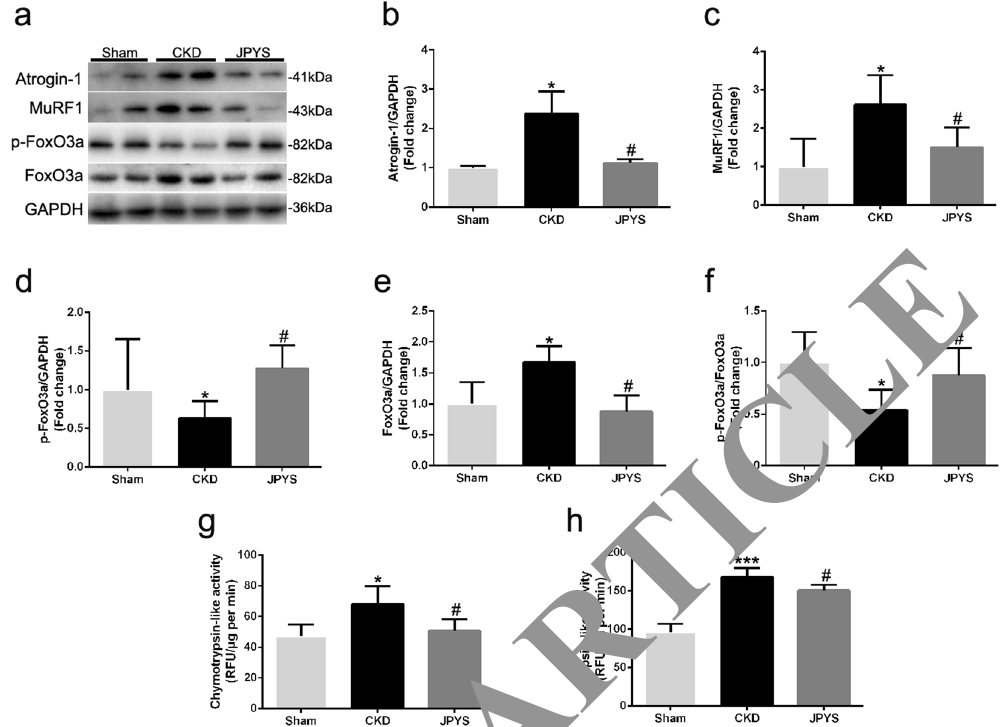
Figure 3. Effect of JPYS decoction on FoxO3a and ubiquitin-proteasome pathway in skeletal muscle of 5/6 nephrectomised rats. ( a ) Representative Western blot images of Atrogin-1, MuRF1, phosphorylated (p) form of FoxO3a and FoxO3a protein expression. ( b ) Quantification of Atrogin-1, (c) MuRF1 protein levels. ( d ) Quantification of p-FoxO3a, ( e ) FoxO3a protein levels and ( f ) FoxO3a/p-FoxO3a ratio. GAPDH was used as loading control. Data are expressed as Fold change vs. Sham and reported as means ± SD, n = 6 per group. ( g ) Chymotrypsin-like activity of the 20 S proteasome in gastrocnemius muscle was measured by using the fluorogenic substrate N-succinyl-Leu-Leu-Val-Tyr-7-amido-4-methylcoumarin. ( h ) Trypsin-like activity of the 20 S proteasome was measured by using the Boc-Leu-Arg-Arg-7-amido-4-methylcoumarin. Results are presented as mean ± SD, n = 6 per group, * P < 0.05, *** P < 0.001 between Sham and CKD groups. # P < 0.05 between CKD and JPYS